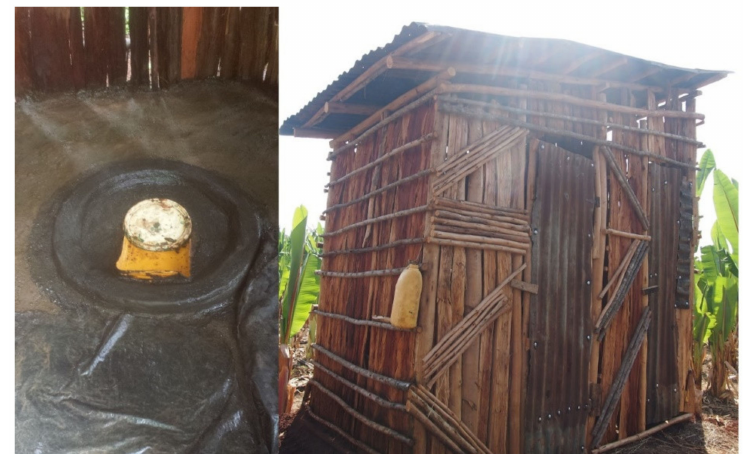
Figure 2. An improved latrine (left: inside, right: